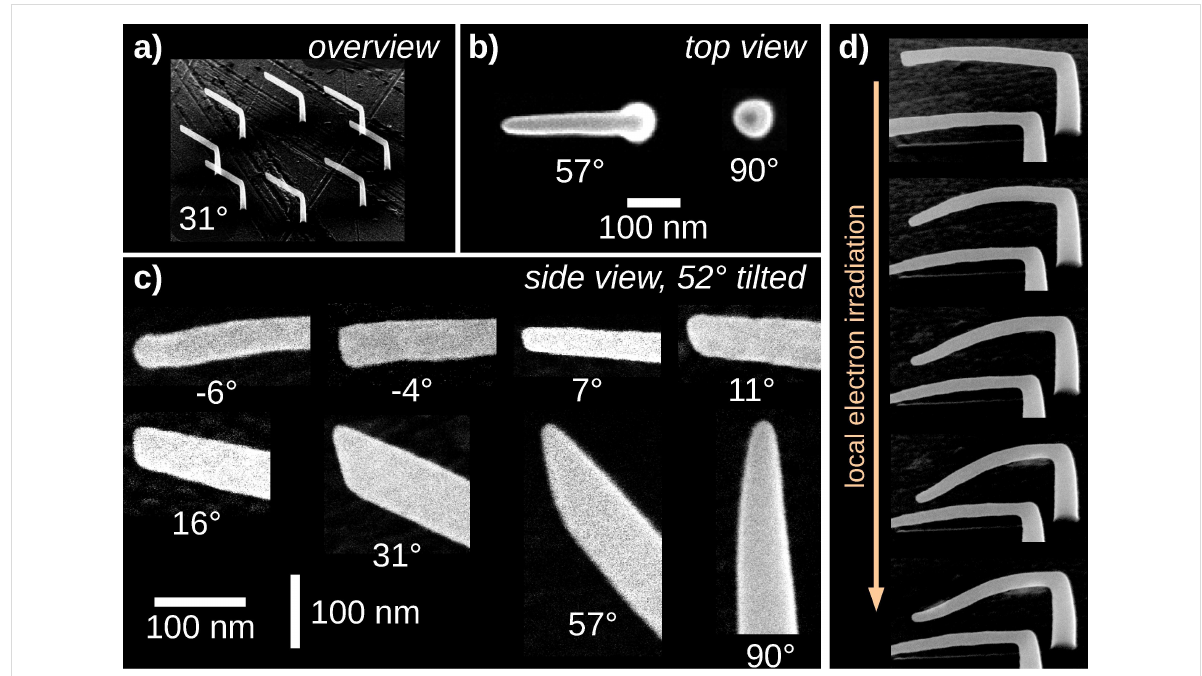
Figure 15: In order to investigate the shape of edge tips with different edge inclination, deposits like shown in a) were prepared. They consist of eight identical elements, written in parallel, in order to guarantee sufficient refresh time for precursor replenishment. b) Tip shapes as viewed from top. Since the deposits’ shape can be modified by the image acquisition, no images for edges with smaller inclination angles are shown. c) Tip shapes from a 52° tilted view. The exact shape of a tip will influence the ratio of secondary electrons leaving the edge’s top and side surfaces. An improved inclination-angle-dependent interpolation function for the deposition speed s F could use this information. d) Influence of electron irradiation on the shape of 3D structures. Even the relatively small electron dose applied during image acquisition of a deposit can lead to shape changes in quite dramatic ways. Precursor: Me 3 CpMePt(IV), normal